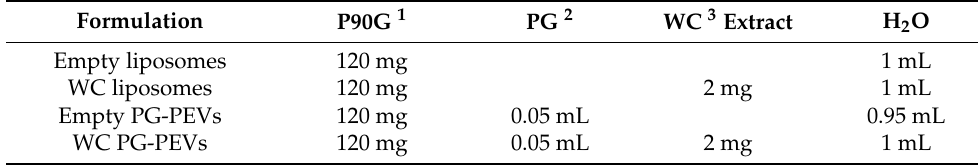
Table 1. Composition of vesicle formulations.